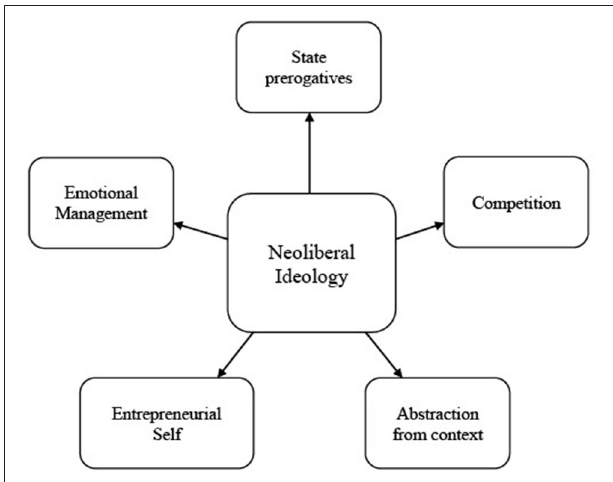
FIGURE 1 | Dimensions of neoliberal ideology in